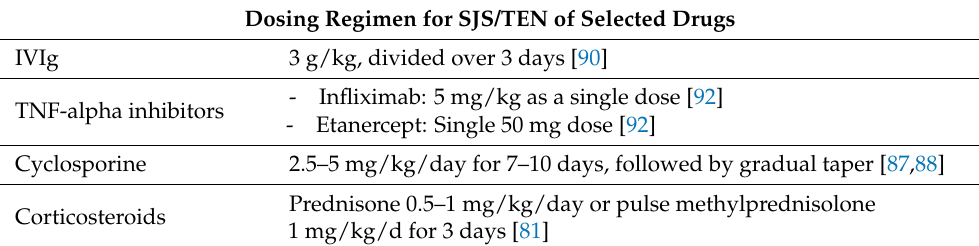
Relative Cost of Selected Drugs **